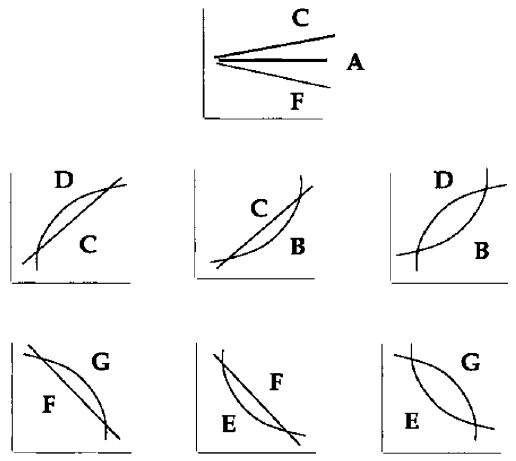
Figure 7. Similarity or dissimilarity of fuzzy species between patterns.